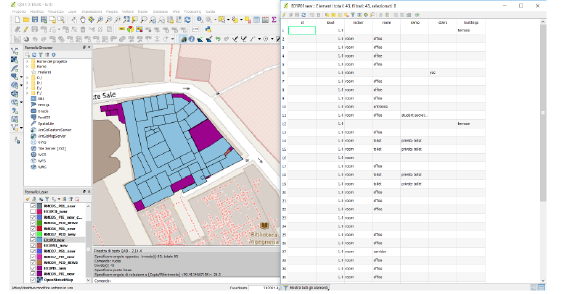
Figure 2. The translated layout of the first floor of faculty of Civil and Industrial Engineering building